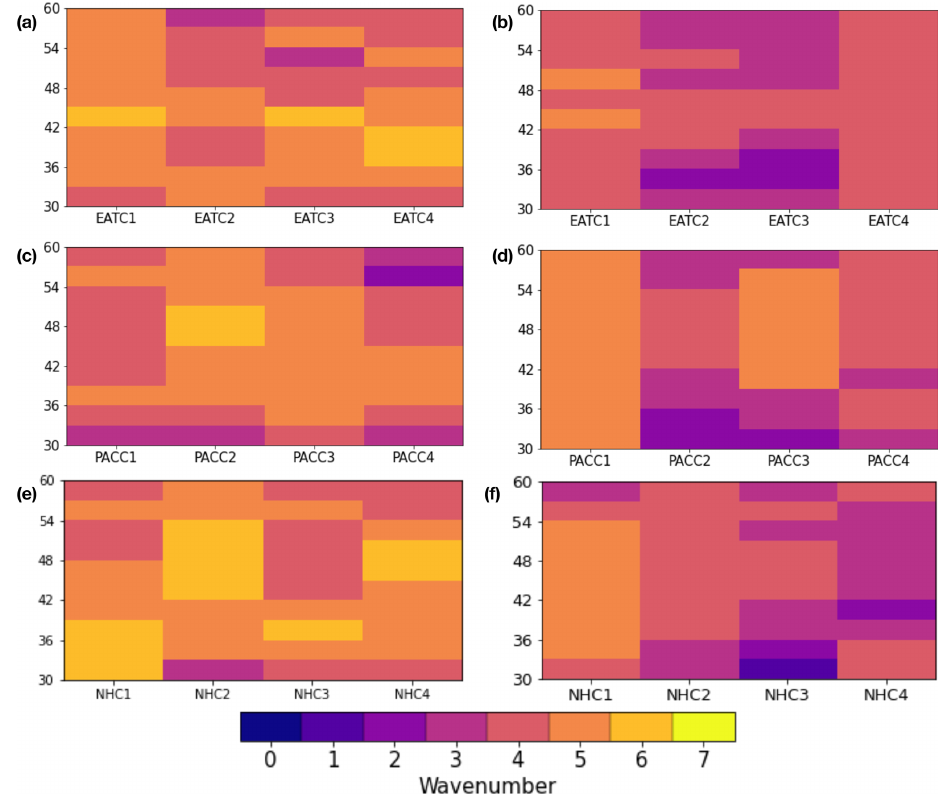
Figure 10. Same as in Fig. 9, for